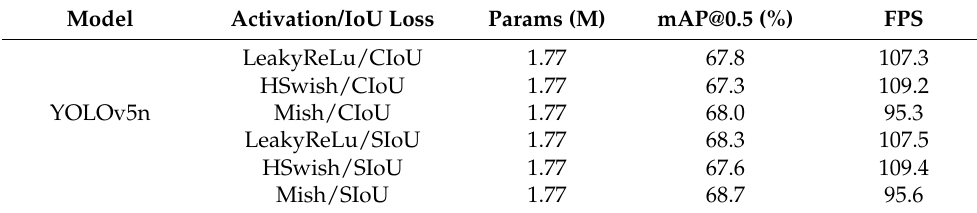
Table 2. The comparison results of different activation functions and IoU loss under the same model.